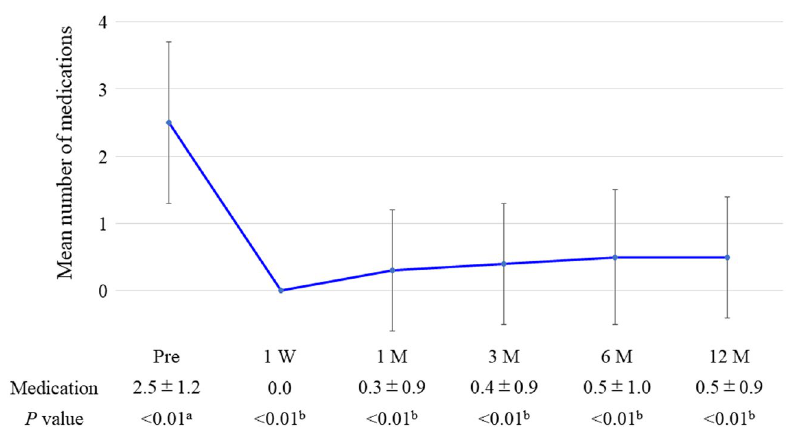
Figure 2 . Changes in the mean number of glaucoma medications throughout follow-up. The error bar shows the standard deviation. W, week; M, month. P -values: a one-way repeated measures ANOVA; b paired t -test versus baseline with Bonferroni correction.